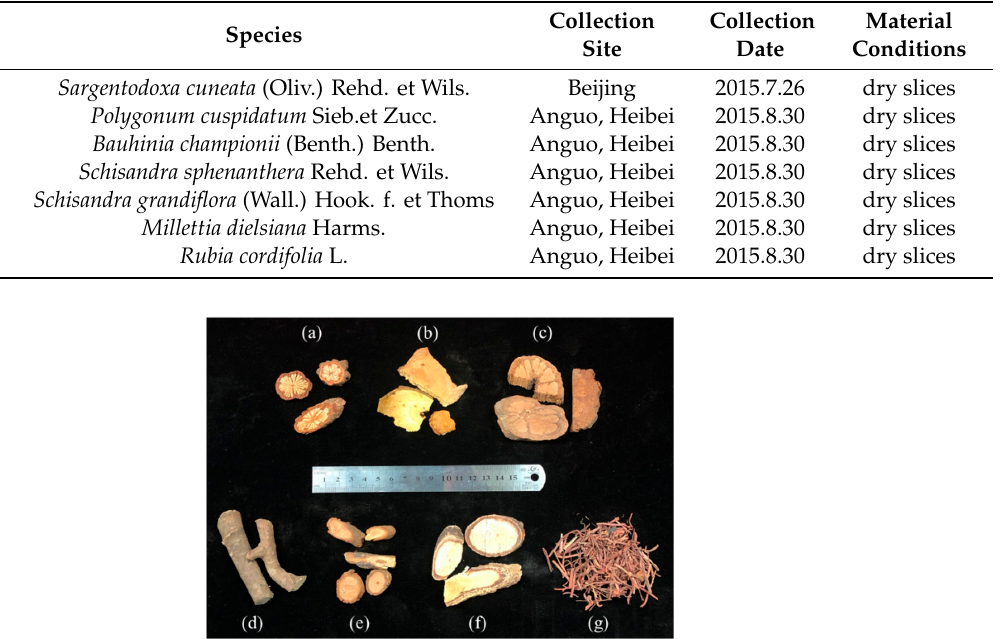
Table 3. Collected herbs: S. cuneata and its six adulterants.